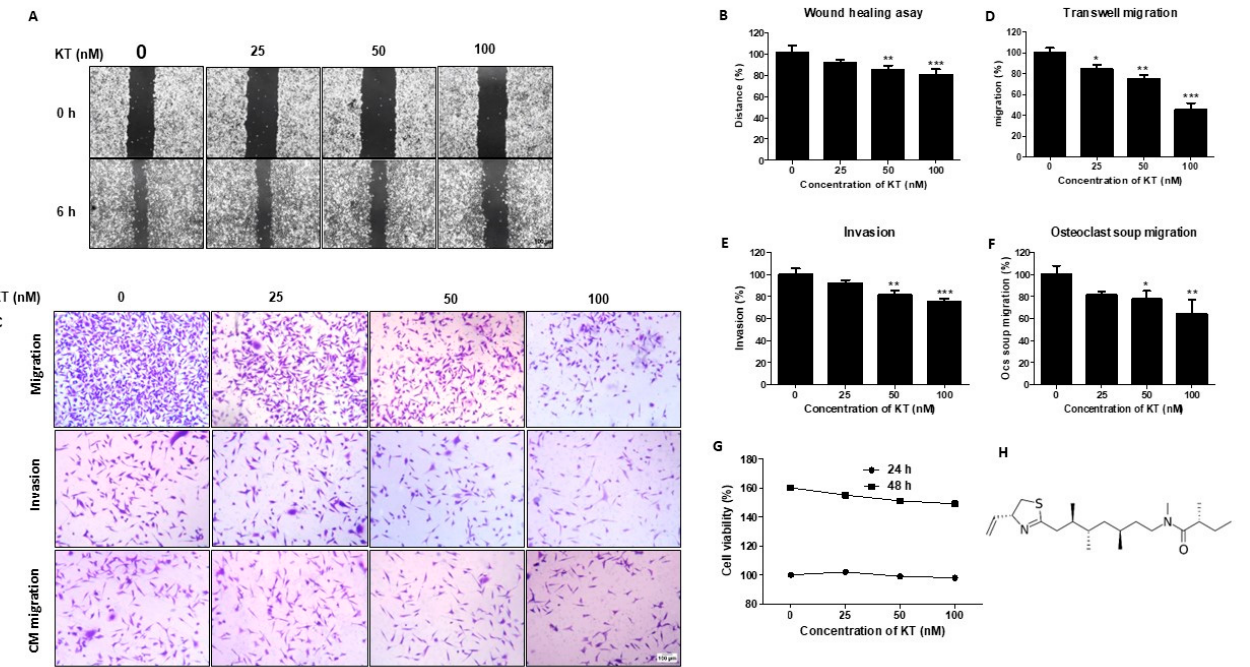
Figure 1. Kalkitoxin suppresses the migration of MDA-MB-231 cells. Cells were cultured with DMEM high glucose (growth media) with or without 25, 50, and 100 nM concentrations of KT. ( A ) Wound healing assay (Scale bar, 100 µ m) ( C ), transwell migration, transwell invasion assay, and CM migration were observed (Scale bar, 100 µ m). ( B , D – F ) Quantitative analysis of the assays with or without KT. ( G ) Effect of different concentrations of KT on MDA-MB-231 cells at 24, 48, and 72 h, observed by MTT assay. ( H ) Molecular structure of kalkitoxin. Results are presented as means ± S.D. ( n = 3). * p < 0.05, ** p < 0.01, and *** p < 0.001 indicate significant differences between KT-treated